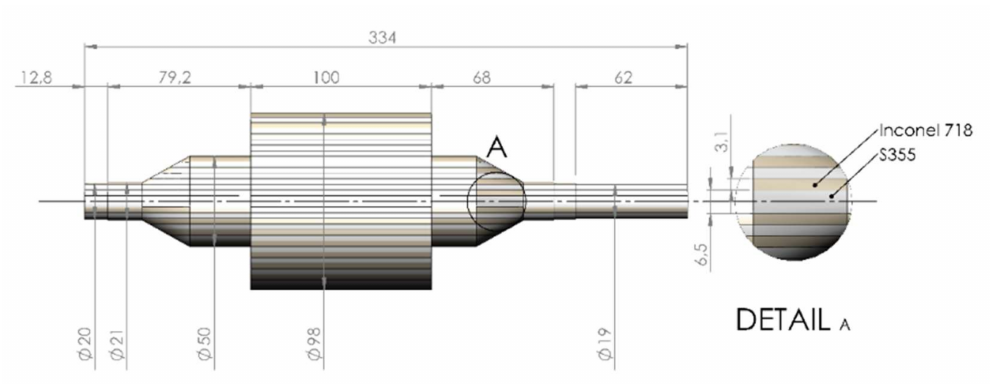
Figure 4. Main dimensions and laminate layer configuration of the laminated rotor. (Dimensions in millimeters, not to scale.) Table 4. Material properties used in finite element analysis of the laminated rotor